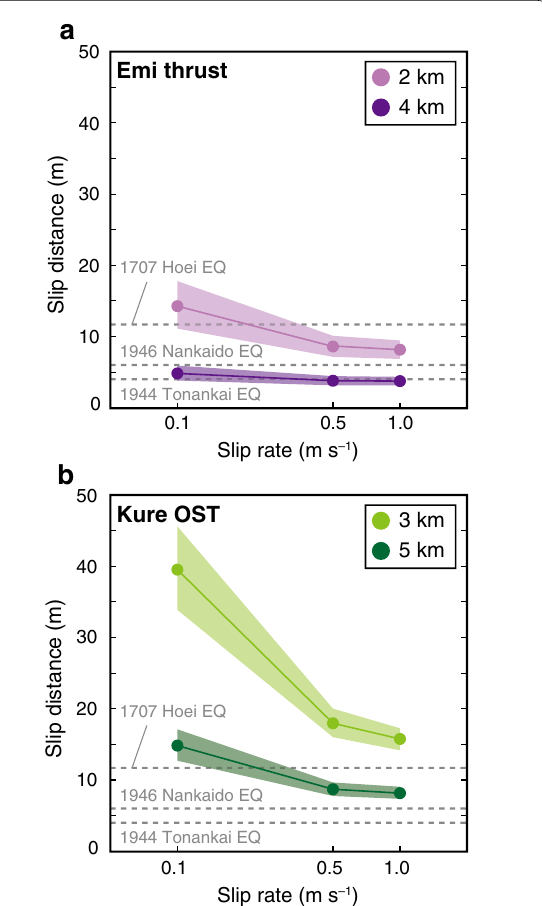
Fig. 7 Results of numerical simulations of heating during fault slip used to determine the amounts of slip necessary to achieve the target temperatures. a 700 100 °C in the ultracataclasite layer in the ± Emi major thrust. b 1300 100 °C in the pseudotachylyte layer in the ± Kure OST for different slip rates and depths of burial. Slip distances during three historical earthquakes are referred from Ando (1975) and Furumura et al.